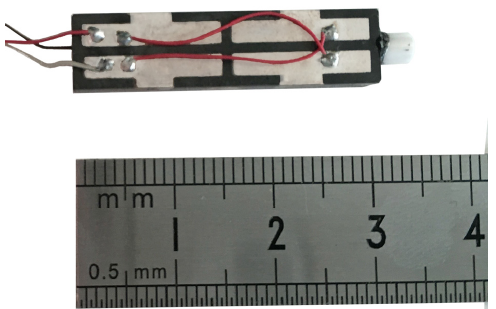
Figure 5. Photo of the piezoelectric vibrator.